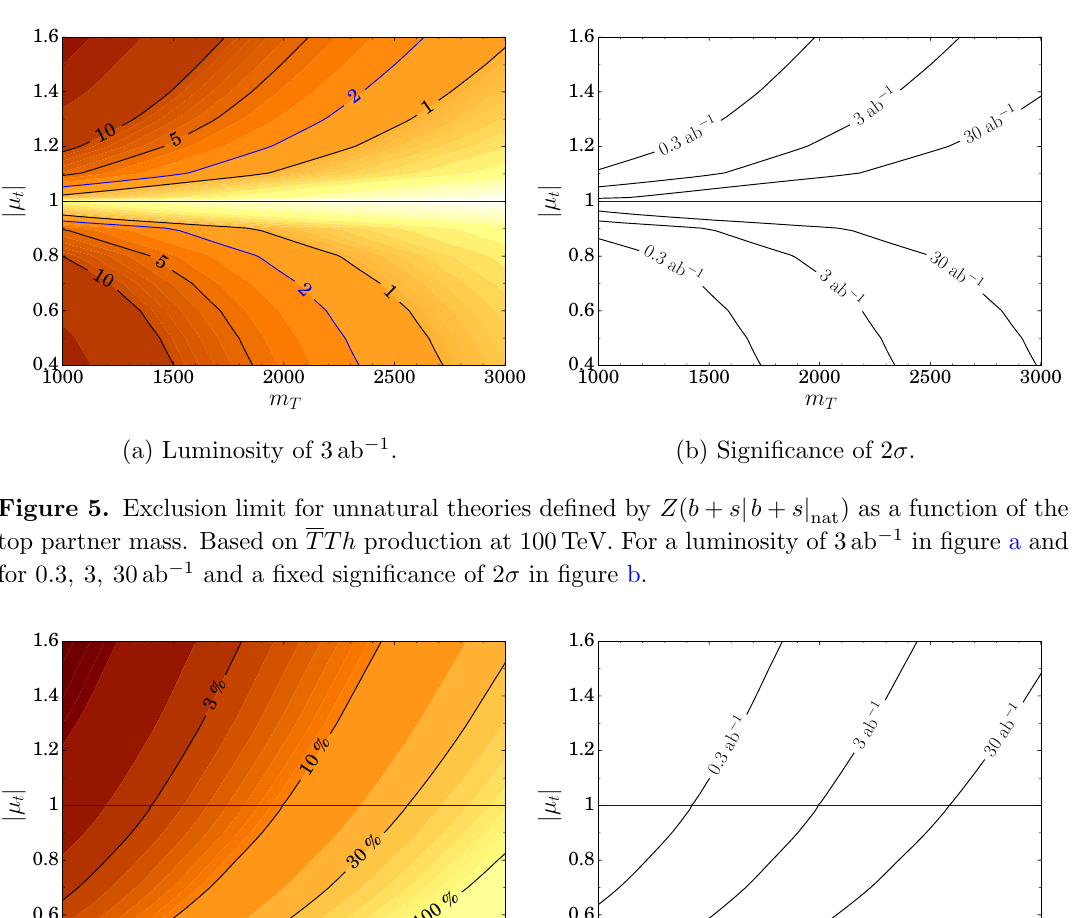
(cid:22) t at 3 ab (cid:0) 1 j j